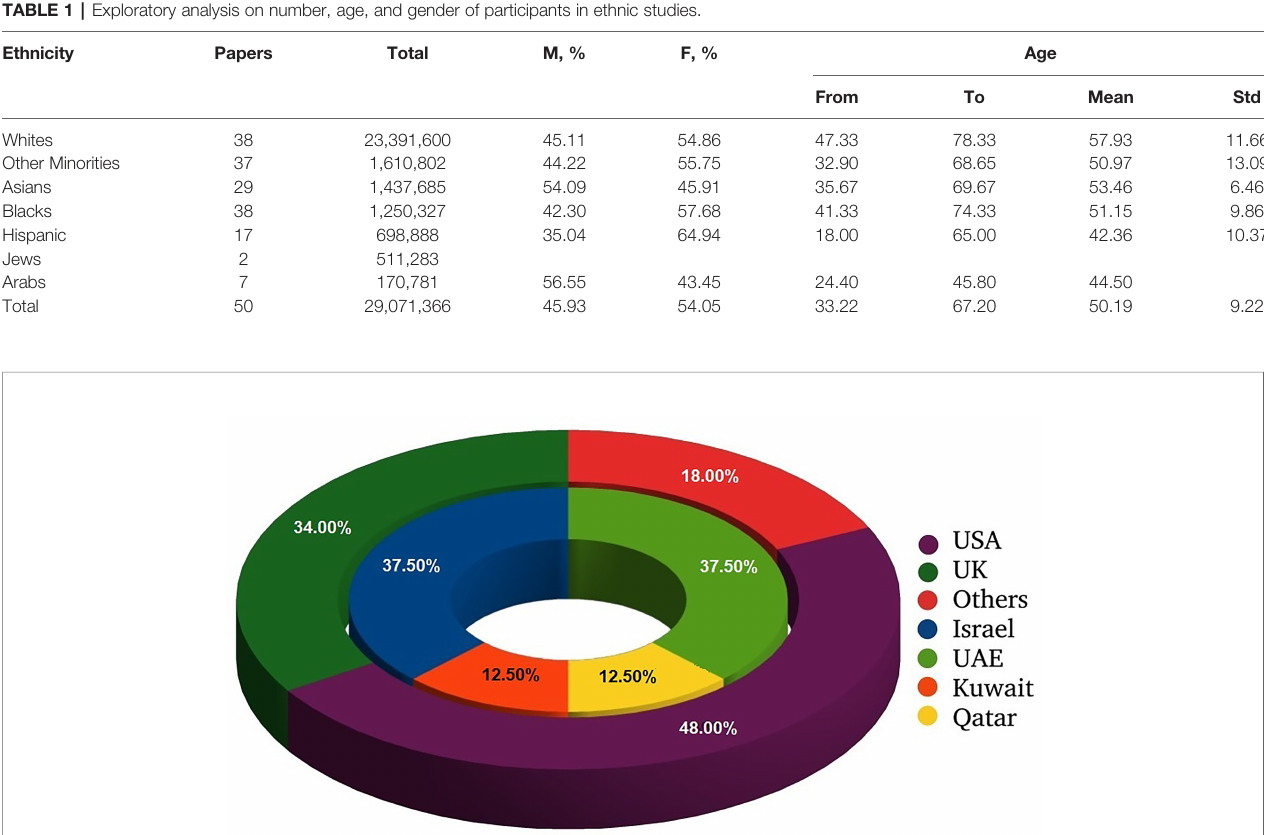
TABLE 1 | Exploratory analysis on number, age, and gender of participants in ethnic studies. Ethnicity Papers